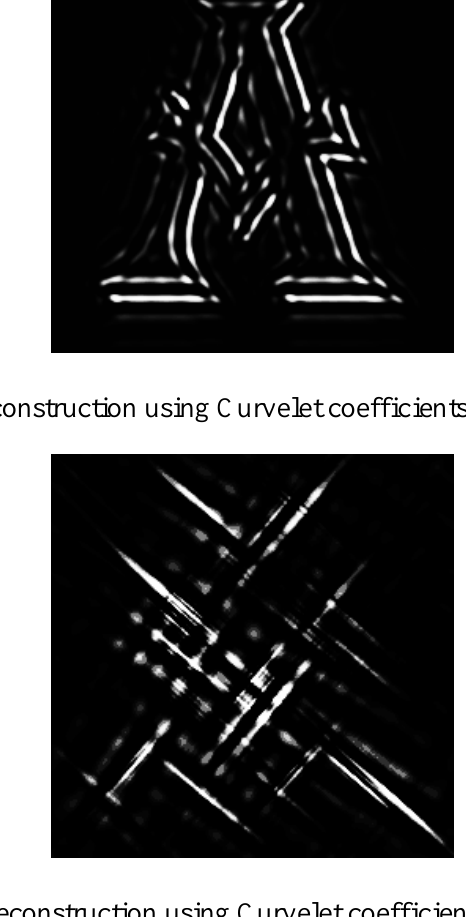
Figure 5. Image reconstruction using Curvelet coefficients of center